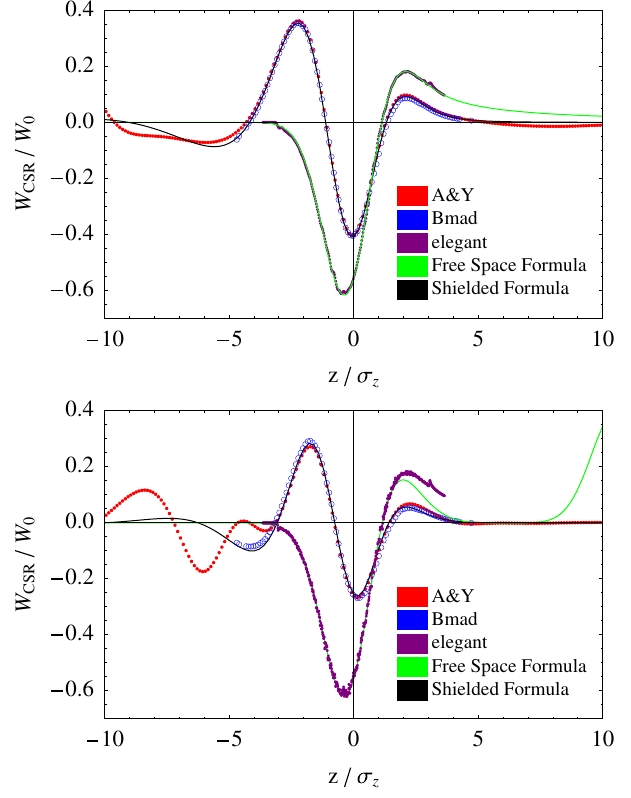
FIG. 14. (Color) Realistic magnets: Parameter set E (JLab TH2 magnet) line (top), set F (CESR analyzer magnet) (bottom). Bmad agrees with the CSR-wake formula Eq. (53) better than the other codes at the bunch